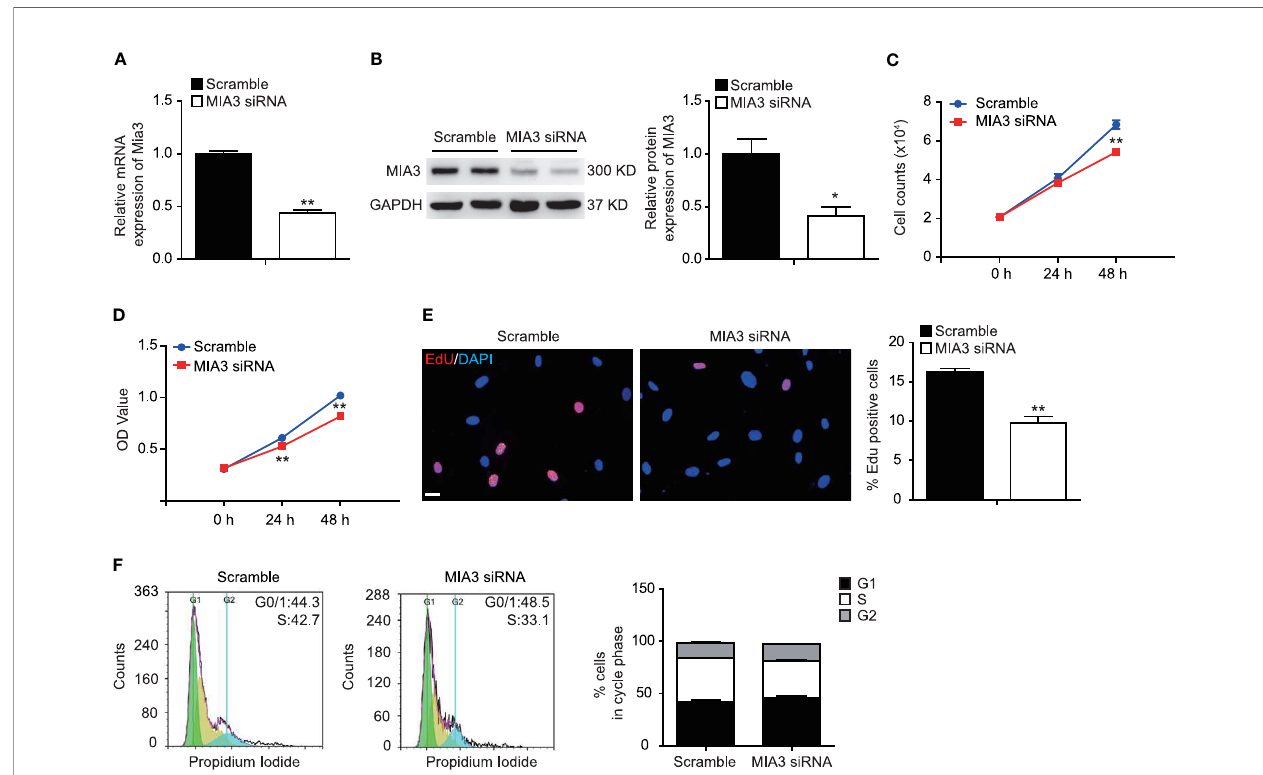
FIGURE 2 | Knockdown of MIA3 inhibits vascular smooth muscle cell (VSMC) proliferation. (A) MIA3 mRNA levels in human aortic smooth muscle cells (HASMCs) with small interfering RNA (siRNA) MIA3 and scramble siRNA. Data are represented as the mean ± SEM, n = 3. ** p < 0.01, t -test. (B) MIA3/TANGO1 protein levels in human aortic smooth muscle cells (HASMCs) with small interfering RNA (siRNA) MIA3 and scramble siRNA with quantitative data at right. GAPDH served as loading control expression. Data are represented as the mean ± SEM, n = 3. * p < 0.05, t -test. (C, D) VSMC proliferation was determined by cell counts (C) and 3-[4,5- dimethylthiazol-2-yl]-2,5 diphenyl tetrazolium bromide (MTT) assay (D) in VSMCs with or without transfection of MIA3-speci fi c siRNAs. All data were indicated as the means ± SEM, n = 3. ** p < 0.01, t -test. (E) VSMC proliferation was determined by 5-ethynyl-2 ’ deoxyuridine (EdU) incorporation in VSMCs with or without transfection of MIA3-speci fi c siRNAs. Percentage of EdU staining-positive cells was quanti fi ed on the right. Scale bar: 50 m m. Data are represented as the mean ± SEM, n = 3. ** p < 0.01, t -test. (F) VSMC proliferation was determined by PI-cell cycle analysis in VSMCs with or without transfection of MIA3/TANGO1-speci fi c siRNAs. Data are represented as the mean ± SEM, n = 3, t-test